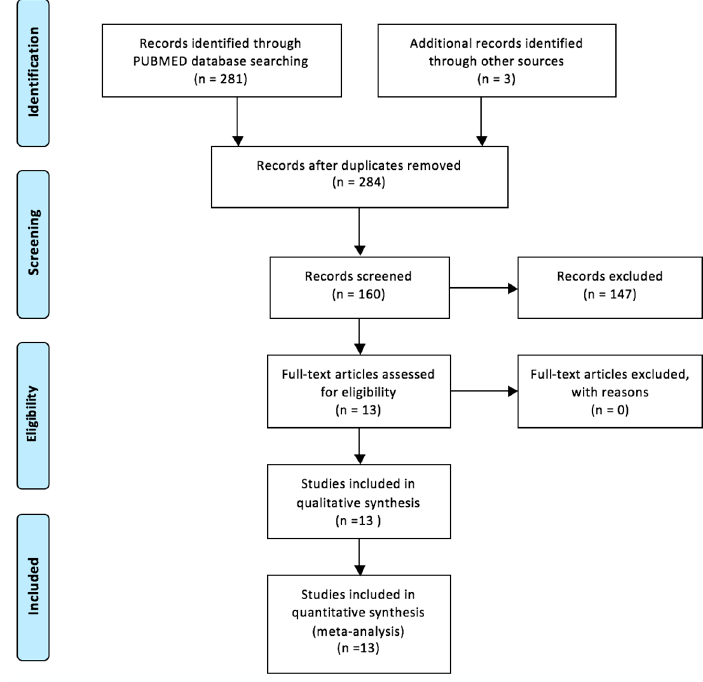
Figure 1. PRISMA flow diagram of selected studies.